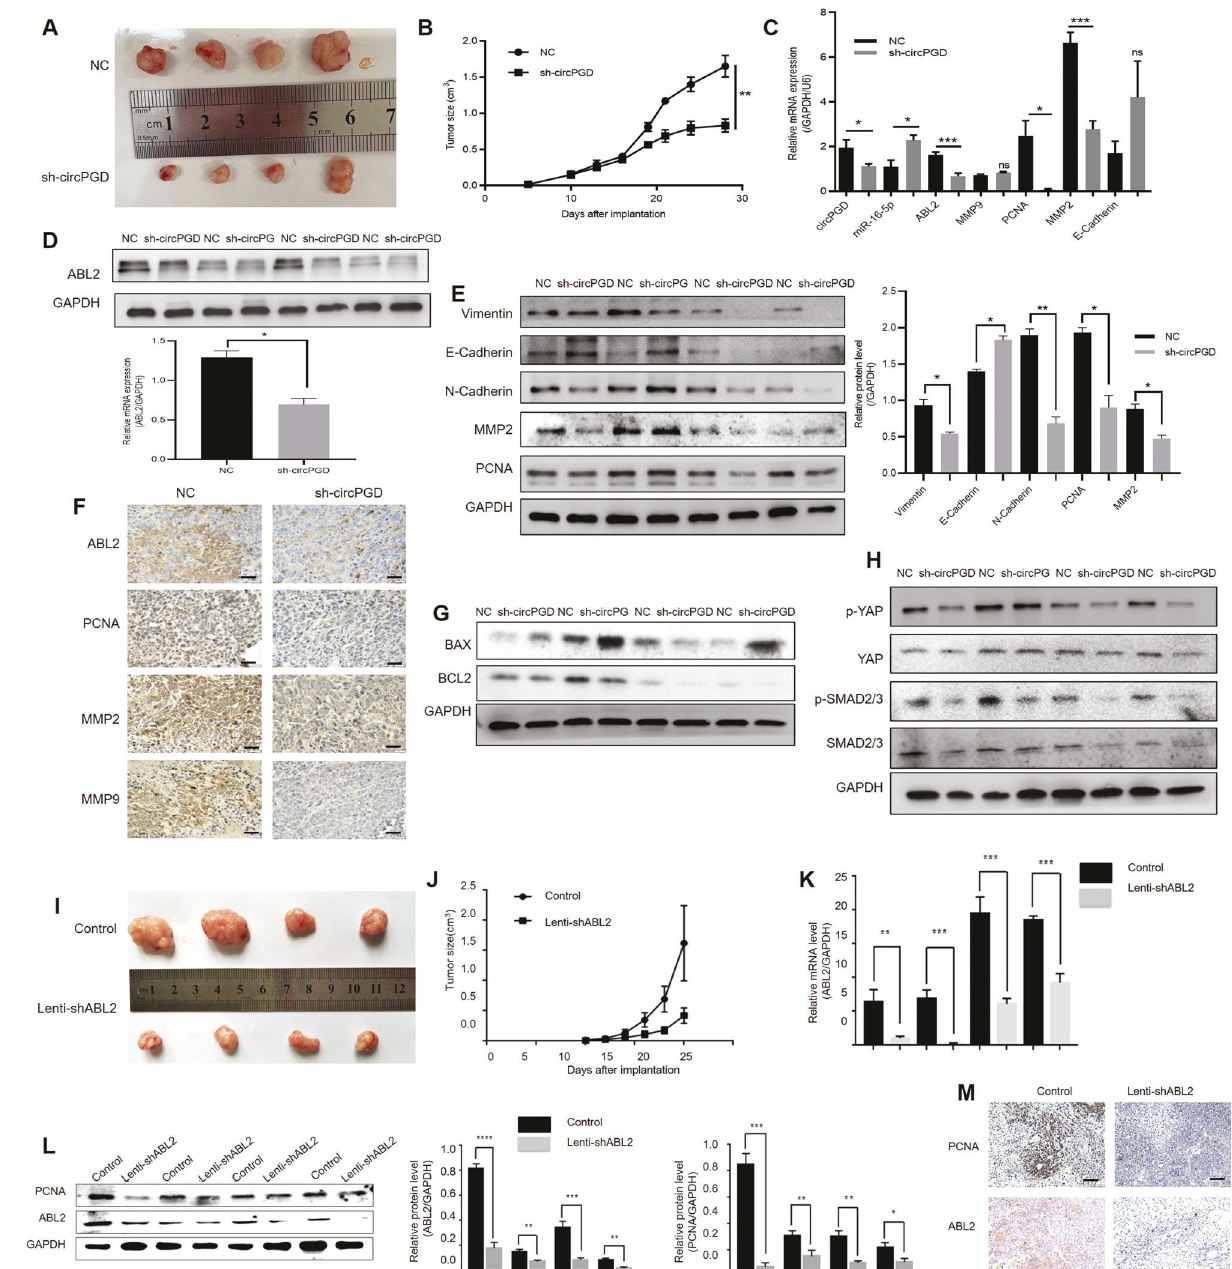
Fig. 7 CircPGD and ABL2 promotes GC cell growth in vivo. A and I Images showing MGC-803 cells induced subcutaneous xenografts. B and J MGC-803 cells induced tumor volumes measured every 3 days for 6 – 8 times. C qRT-PCR analyzed circPGD, miR-16-5p, ABL2, and PCNA mRNA expression within subcutaneous xenograft tumors. D Western blotting analyzed the ABL2 expression level in subcutaneous xenograft tumors. E Western blotting detected the levels of Vimentin, E-Cadherin, N-Cadherin, MMP2, and PCNA expression when circPGD was silenced in subcutaneous xenograft tumors. F ABL2, PCNA, MMP2, and MMP9 expression was observed within subcutaneous xenograft tumors through immunohistochemistry (scale bars = 100 μ m). G and H Western blotting assay conducted to detect proteins related to apoptosis and signaling pathway. K qRT-PCR examined the ABL2 mRNA levels and found that it was low in ABL2-silenced MGC-803 cell subcutaneous xenograft tumors. L ABL2 and PCNA levels were decreased in ABL2-silenced subcutaneous xenograft tumors. M ABL2 and PCNA expression was analyzed within the subcutaneous xenograft tumors through immunohistochemistry (scale bars = 100 μ m). * p < 0.05, ** p < 0.01, *** p <